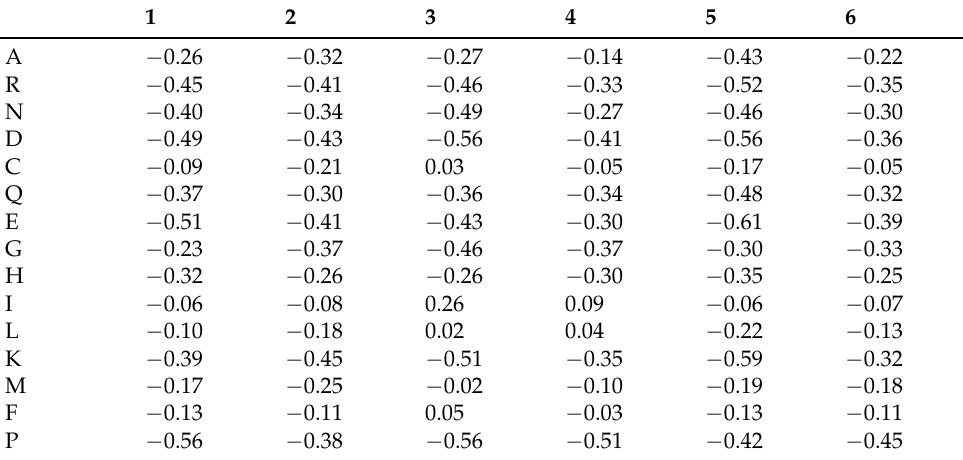
Table 1. The precomputed values from Equation (1) are listed in the rows, corresponding to the amino acids. The columns are correspond to their